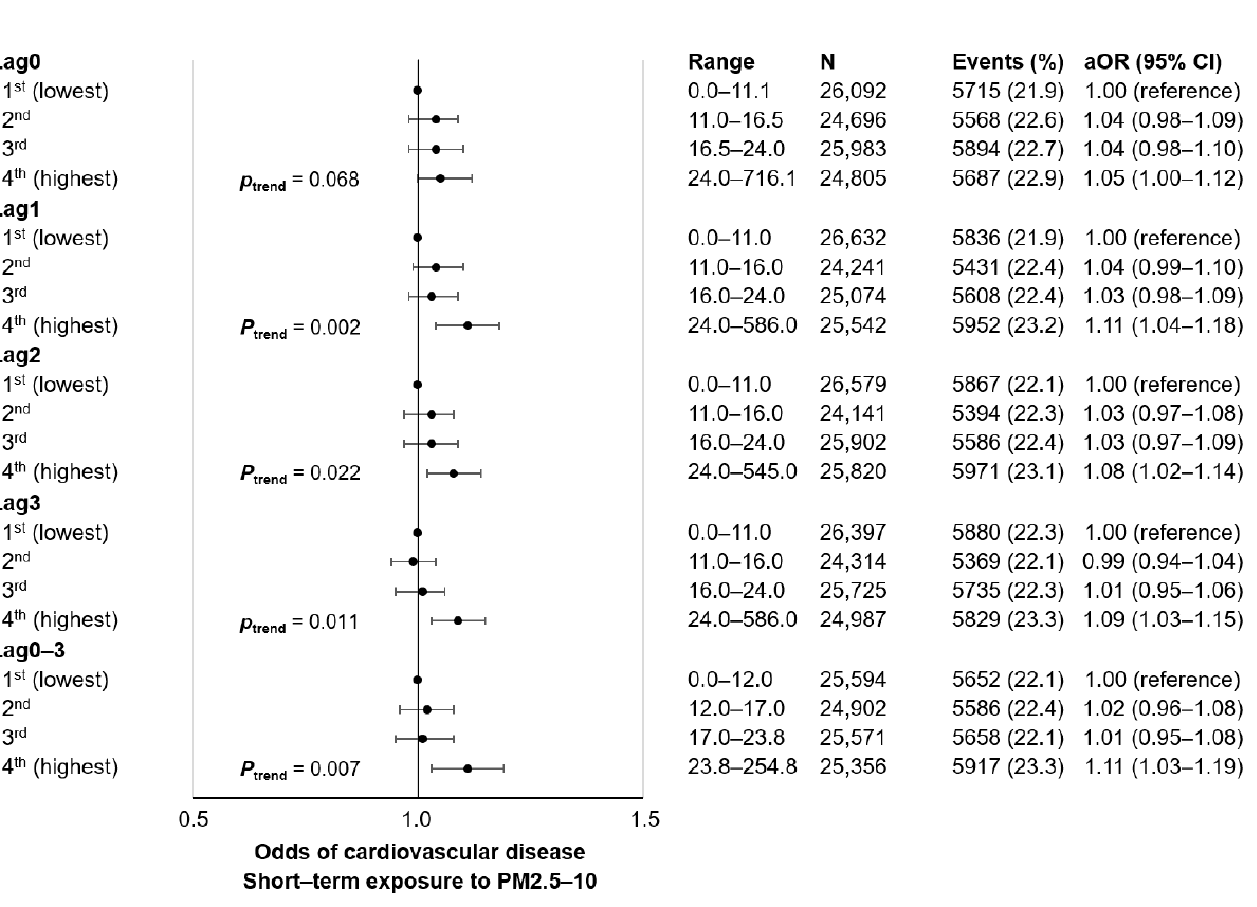
Figure 3. Association of short-term exposure to PM2.5-10 with cardiovascular disease events among 5-year cancer survivors. Adjusted odds ratio calculated by conditional logistic regression after adjustment for mean daily temperature (categorical, 1st, 2nd, 3rd, and 4th quartiles). Acronyms: N, number of participants; aOR, adjusted odds ratio; CI, confidence interval; PM, particulate matter. Table 2. Stratified analysis on the association of short-term PM with cardiovascular disease among 5-year cancer survivors according to subgroups of age, sex, and household